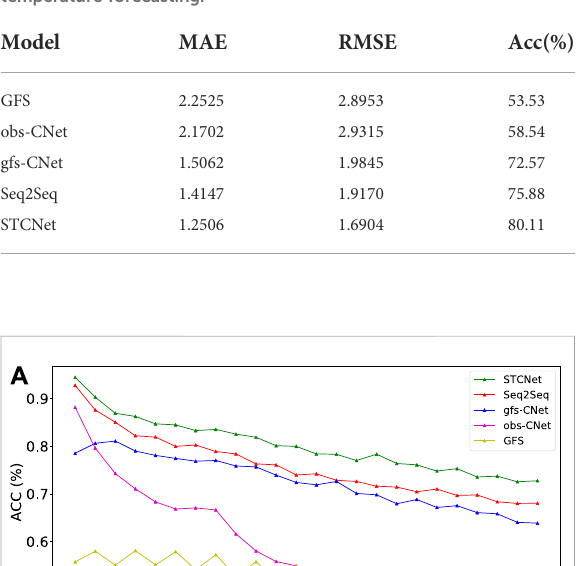
TABLE 3 Comparison of different methods regarding 2-m dewpoint temperature forecasting.